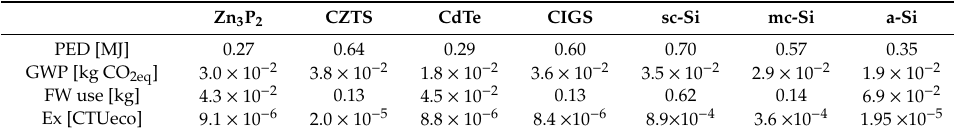
Table 9. Comparison between new thin films and Si-based technologies